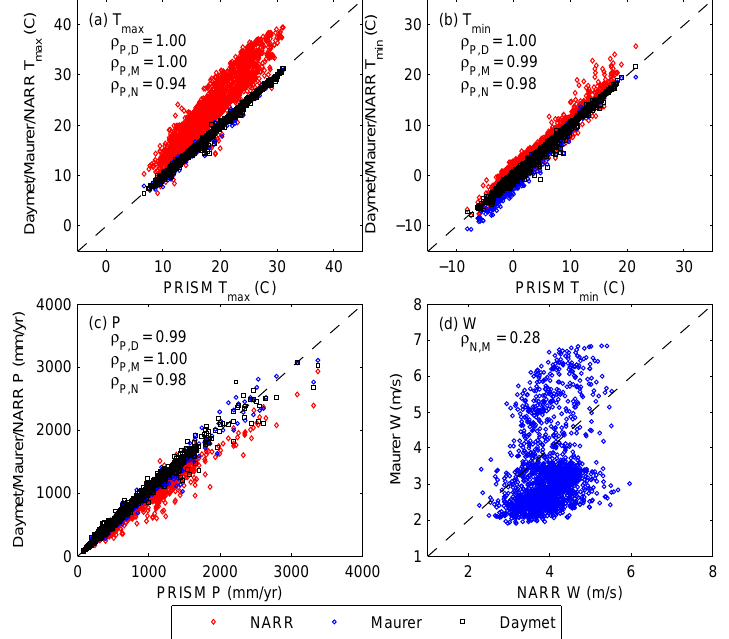
Fig. 3. Comparison among the 1980–2008 PRISM, Daymet, Maurer, and NARR (a) mean daily maximum temperature T max , (b) mean daily minimum temperature T min , (c) annual total precipitation P , and (d) mean daily wind speed W . Each point represents the HUC8 annual average over the entire period.